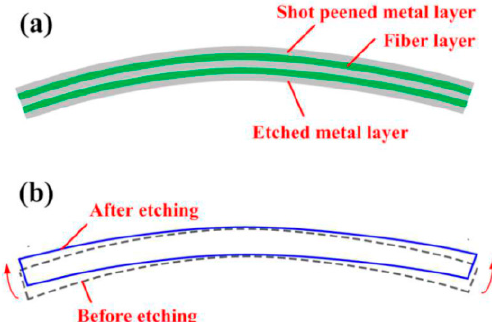
Figure 12. Deformation of shot peened NFMLs after etching: ( a ) schematic diagram of layer removal and ( b ) deformation after etching (reproduced with permission from [138]; copyright© 2021 Elsevier Ltd. All rights reserved.).